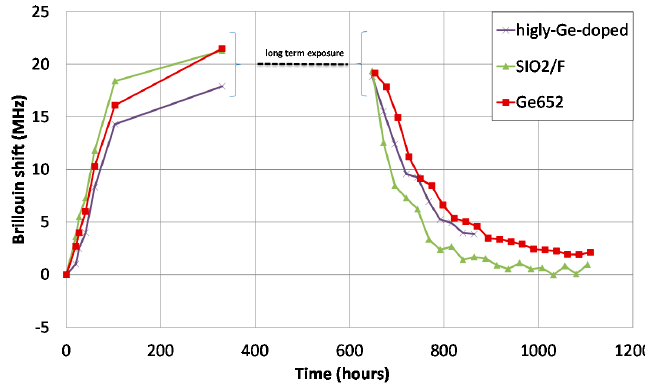
Figure 21. Brillouin frequency shift during the sorption and desorption period for CMS fiber (purple), Fluorine (green) and the most standard commercial G652 type fibre (red).